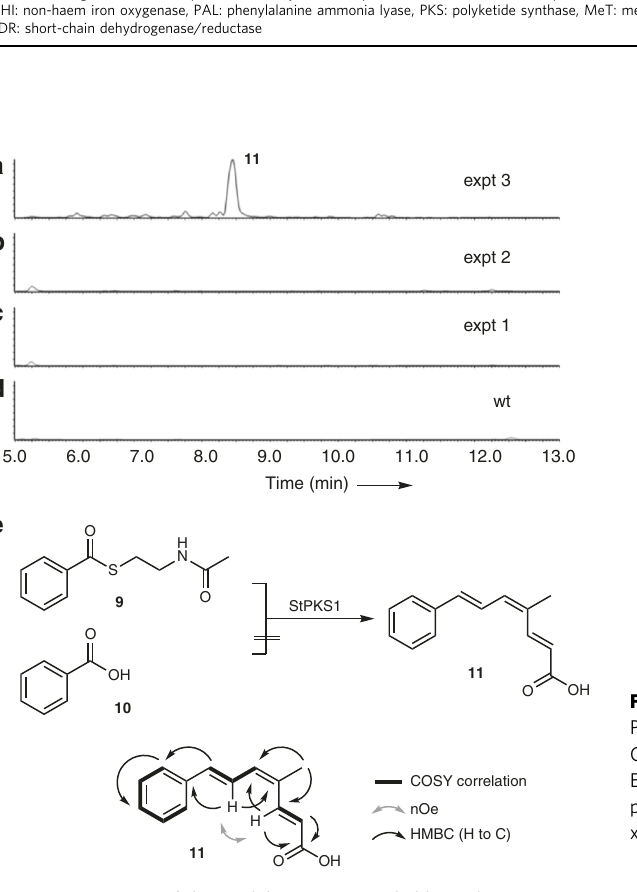
Fig. 3 In vivo activity of the strobilurin PKS encoded by stpks1 . LCMS chromatograms (Diode Array Detector, DAD, 200 – 600 nm, arbitrary units) of extracts of A. oryzae NSAR1: a stpks1 + benzoyl SNAC 9 ; b stpks1 + benzoic acid 10 ; c stpks1 alone; d WT NSAR1, LCMS method 1, LCMS liquid chromatography mass spectrometry. See Table 2 for details; e